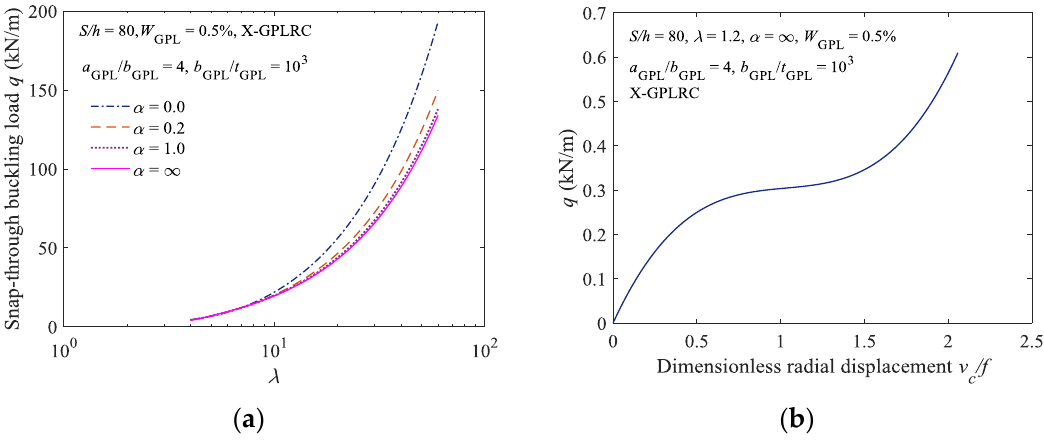
Figure 6. Effect of constraint stiffness and geometry of arches on the limit point buckling load: ( a ) Limit point buckling load; and; ( b ) load displacement curve ( λ = 1.5).